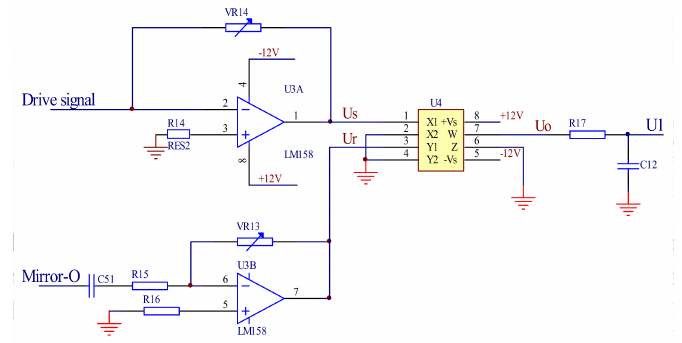
Figure 6. The amplitude detection